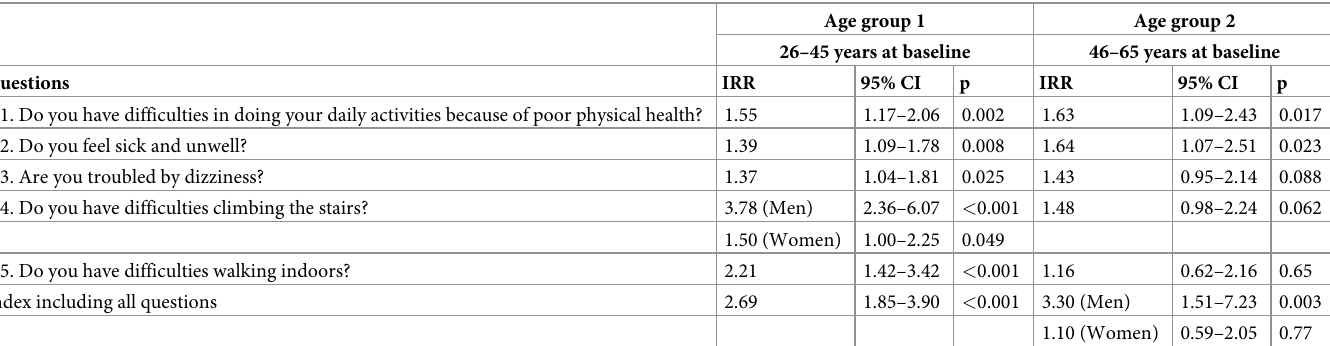
Table 3. Poisson regression of hip fractures, adjusted for gender and time-varying age, with risk according to the five